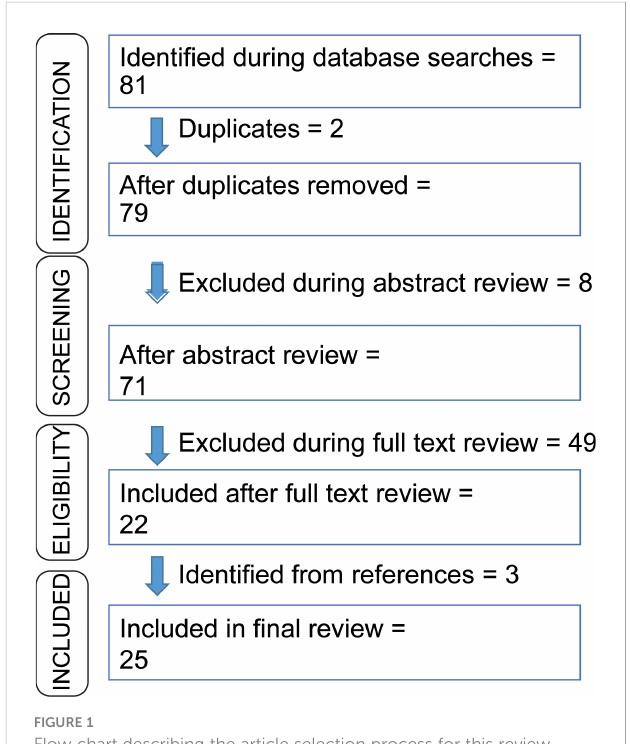
FIGURE 1 Flow chart describing the article selection process for this